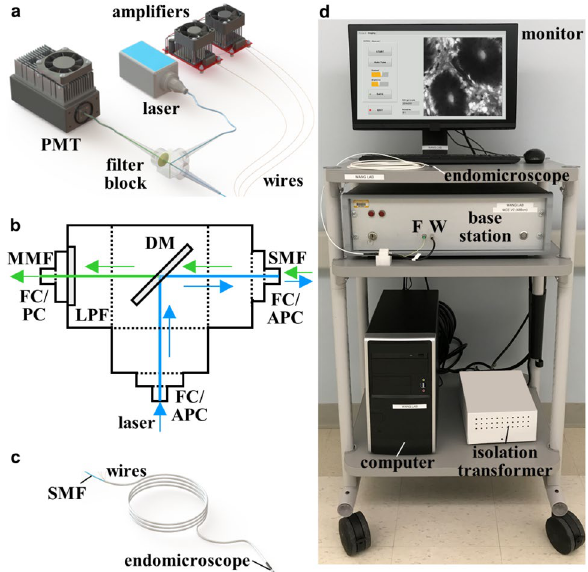
Figure 6. Imaging system. ( a ) The PMT, laser, and amplifiers are contained within the base station. ( b ) In the filter block, the laser (blue) delivers excitation via a fiber pigtail via a FC/APC connector. The beam is